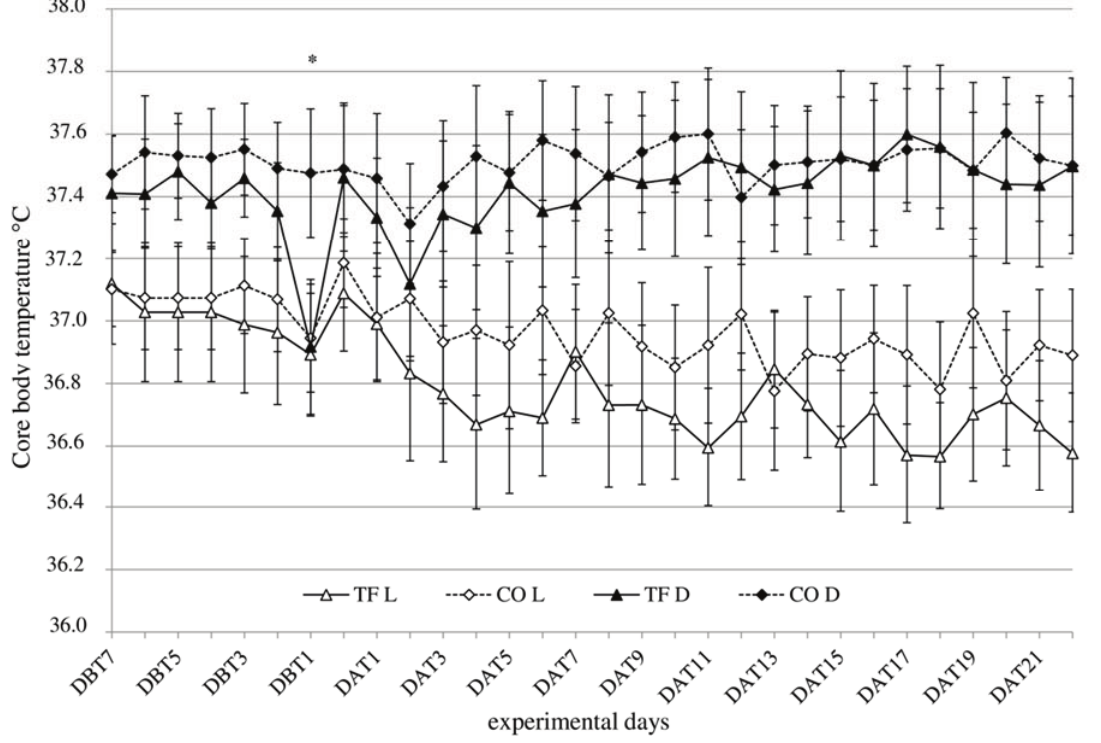
Figure 2. Core body temperature T b (°C ± SD) in transferred (TF: triangles, solid line) and control (CO: diamonds, dotted line) rats during dark (black symbols) and light (white symbols) period, 7 days before (DBT) until 22 days after (DAT) transfer ( n = 16), sexes pooled. * indicates significant difference between TF and